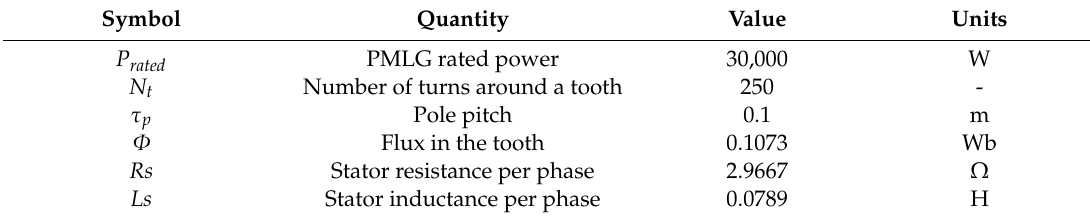
Table 2. Permanent magnet linear generator